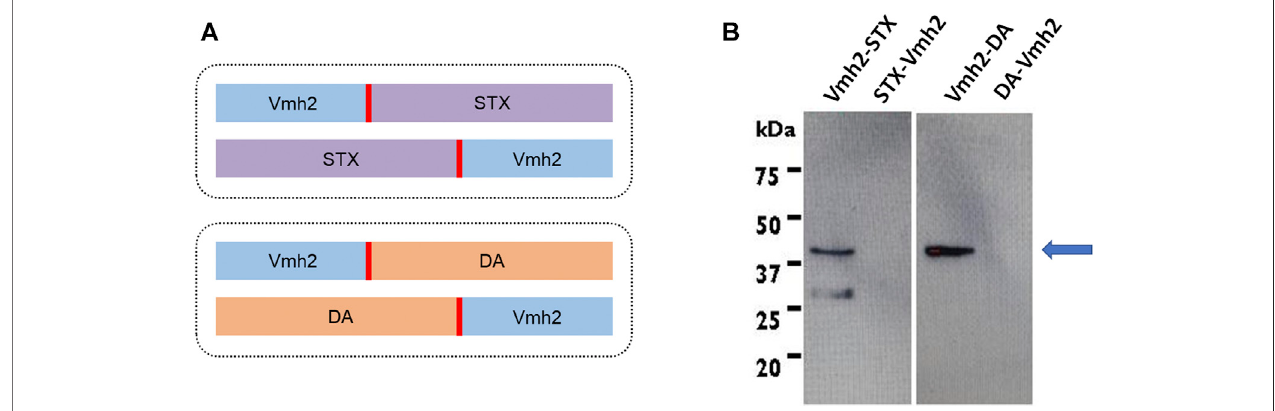
FIGURE 1 | (A) Schematic representation of gene constructs [in blue, the hydrophobin; in red, the (Gly 4 Ser) 3 linker; in violet, the ScFv against saxitoxin; and in orange, that ScFv against domoic acid]; (B) Western blotting analysis of the E. coli inclusion bodies. The arrow indicates the expected molecular weight of the chimeras